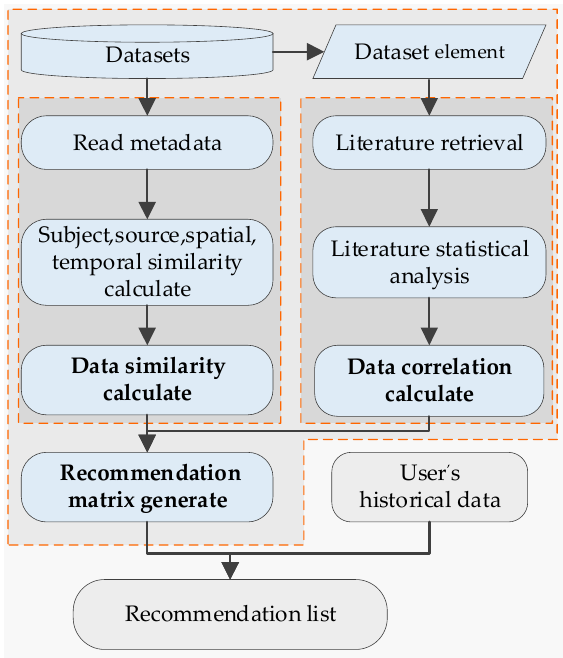
Figure 3. Recommendation process.